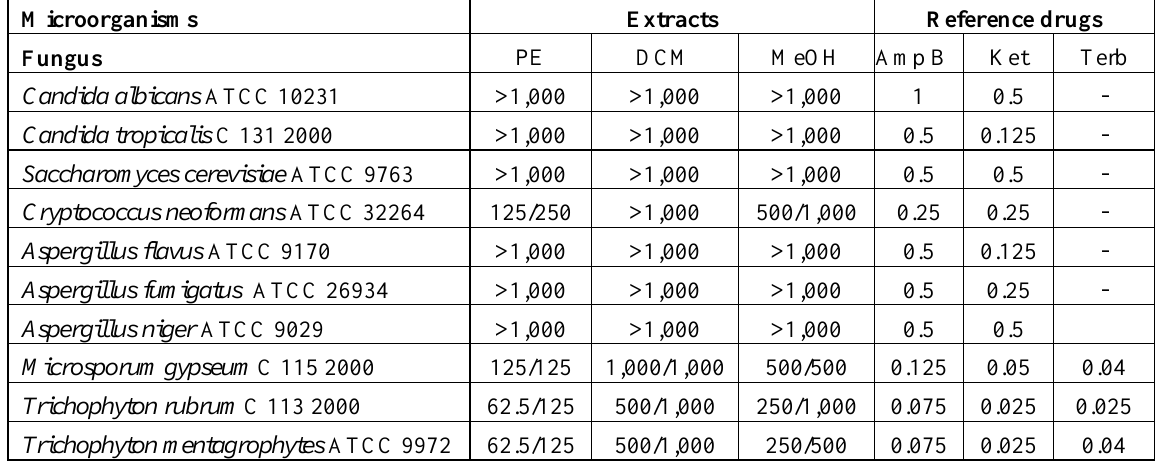
Table1. Antifungal and antibacterial activity to Baccharis darwinii extracts (MIC/MFC, µg/mL). Microorganisms Extracts Reference drugs Fungus